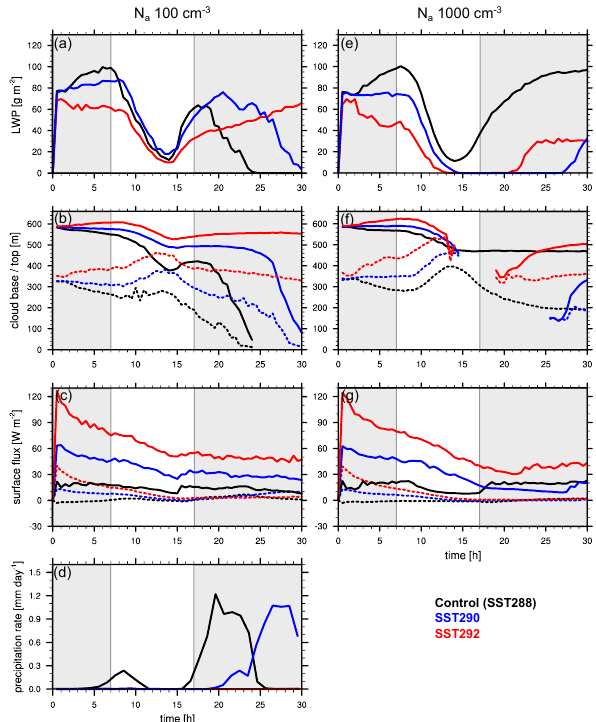
Fig. 6. Time evolution of 1 × 1 km 2 clean ( N a =100cm − 3 , left column) and polluted ( N a =1000cm − 3 , right column) cloud for Control (black), SST290 (blue) and SST292 (red) case: (a) and (e) average LWP; (b) and (f) average cloud top/base height; (c) and (g) domain average surface latent (solid line) and sensible (dashed line) heat flux; (d) surface precipitation rate, hourly averaged.